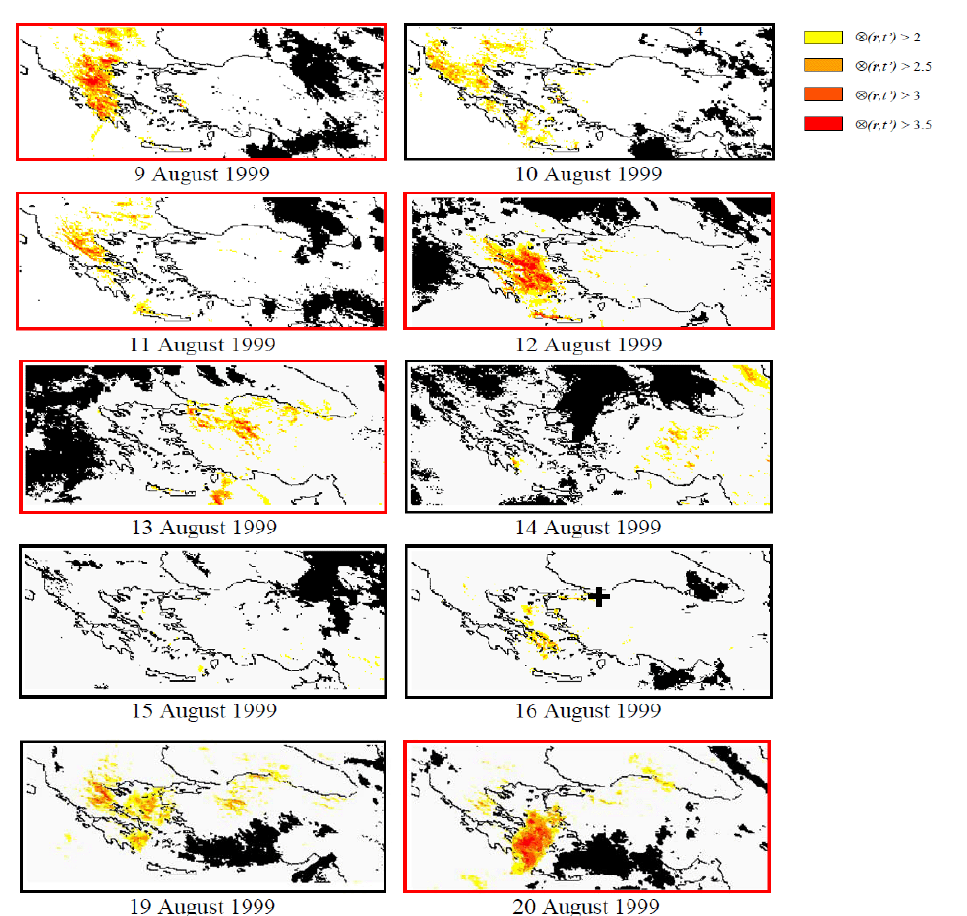
Figure 16. Results of the RETIRA index computation during August 1999 for the Izmit earthquake (M = 7.8, 17 August 1999, Turkey). Cloudy locations (no data) are depicted in black. Pixels with ⊗ ( r,t ) > 3.5 are depicted in red. The black cross, on August 16th, indicates the epicentral area of the Izmit earthquake. Red boxes contour images showing pixels with ⊗ ( r,t ) > 3.5. All scenes refer to Meteosat TIR observations collected at 24:00 GMT)